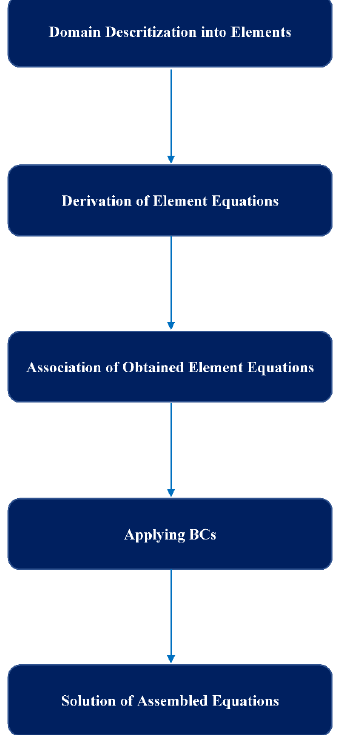
Figure 4. Flow diagram of the numerical solution.